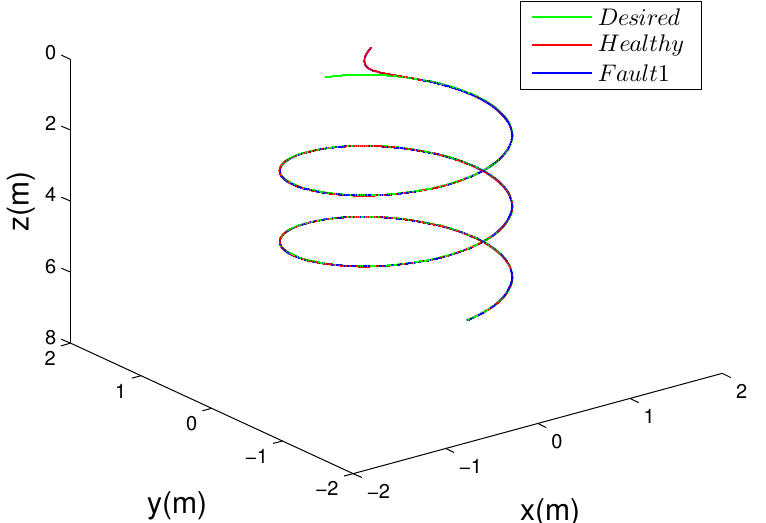
Figure 4. The 3-D trajectory tracking results with fault 1.